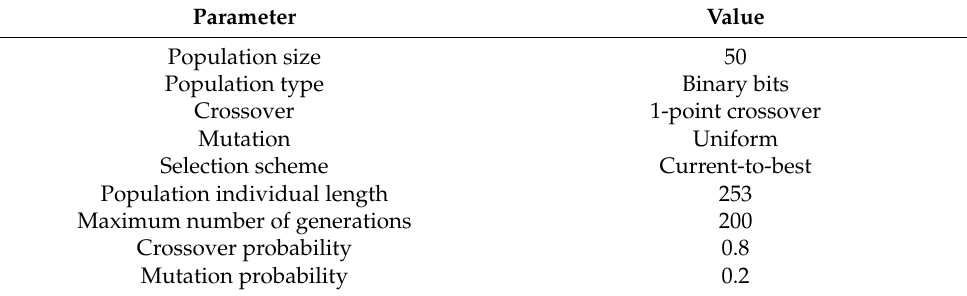
Table 1. DE control parameters